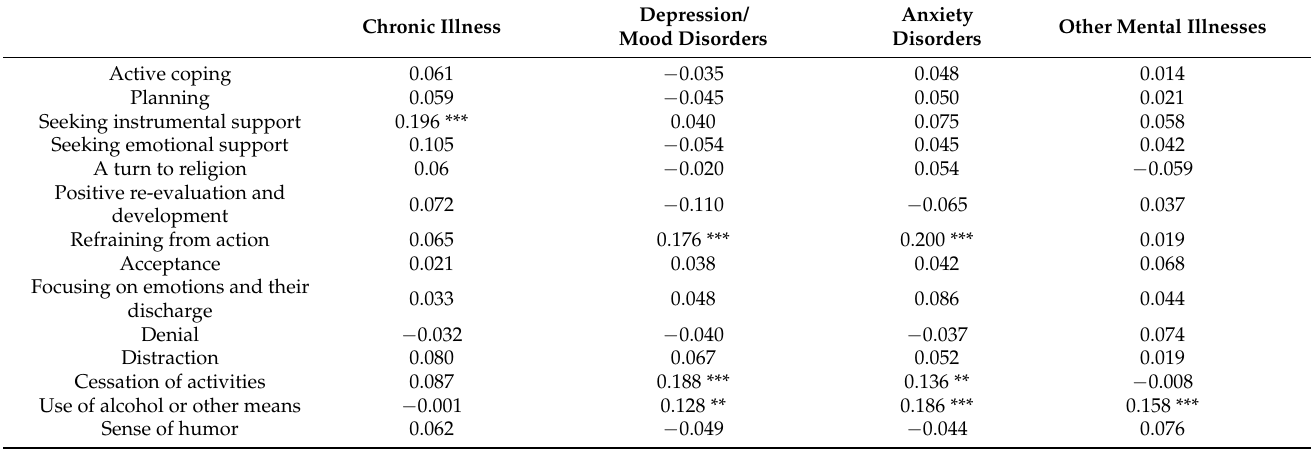
Table 12. Correlations between health problems and MiniCOPE scales.